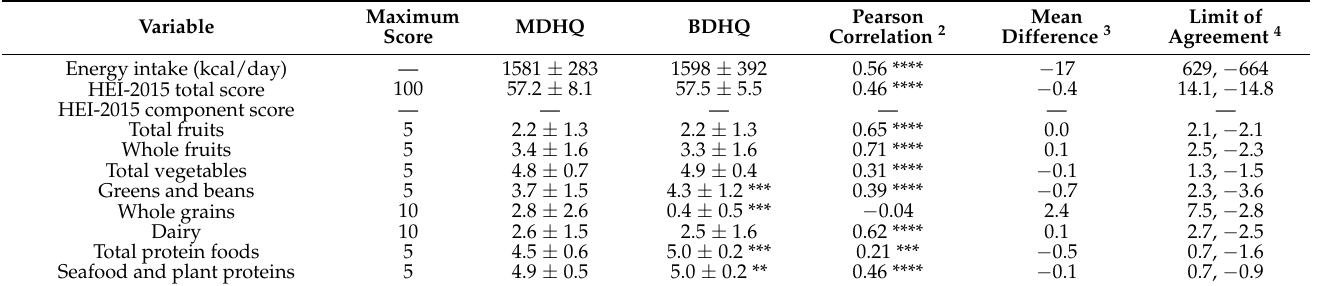
Table 2. Energy intake and the HEI-2015 scores calculated based on the MDHQ and BDHQ ( n = 255) 1 .